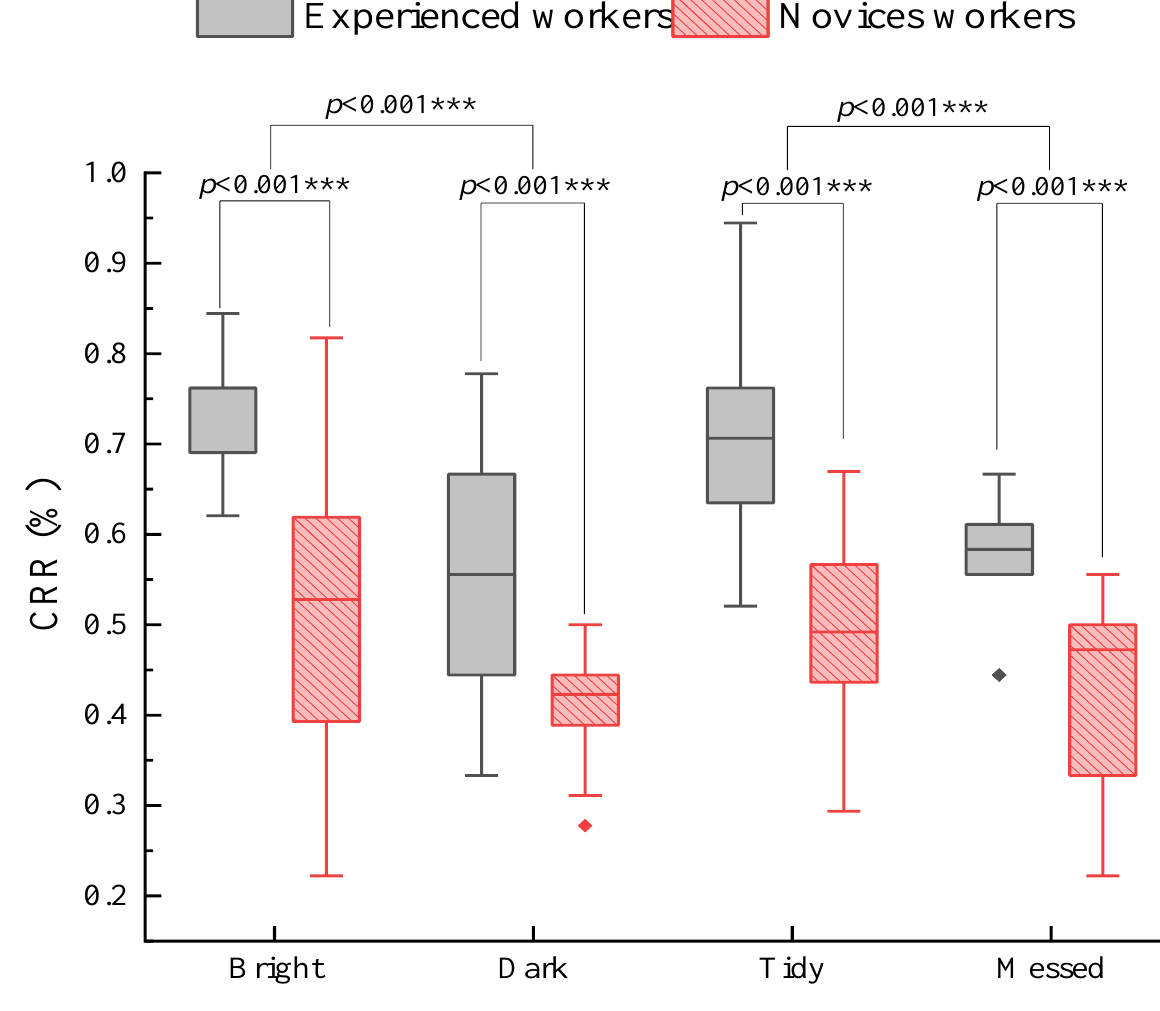
Figure 4. CRR for experts and novices in construction sites with various environmental conditions. (*** indicate significant differences at the 0.001 level.)